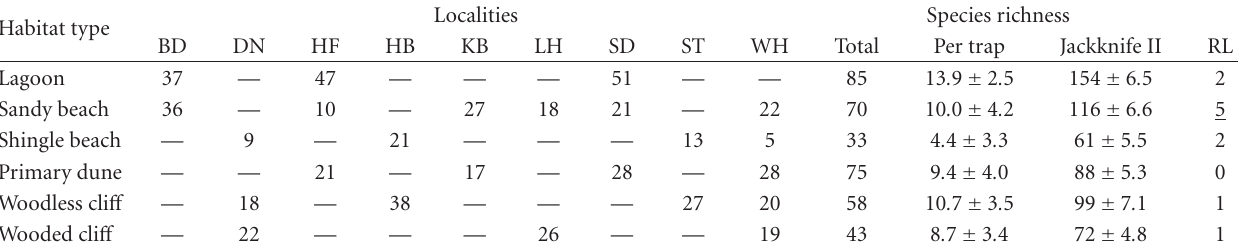
Table 3: Species richness in the investigated habitats and Jackknife II species richness; RL species richness of endangered species (only status 1 and 2).